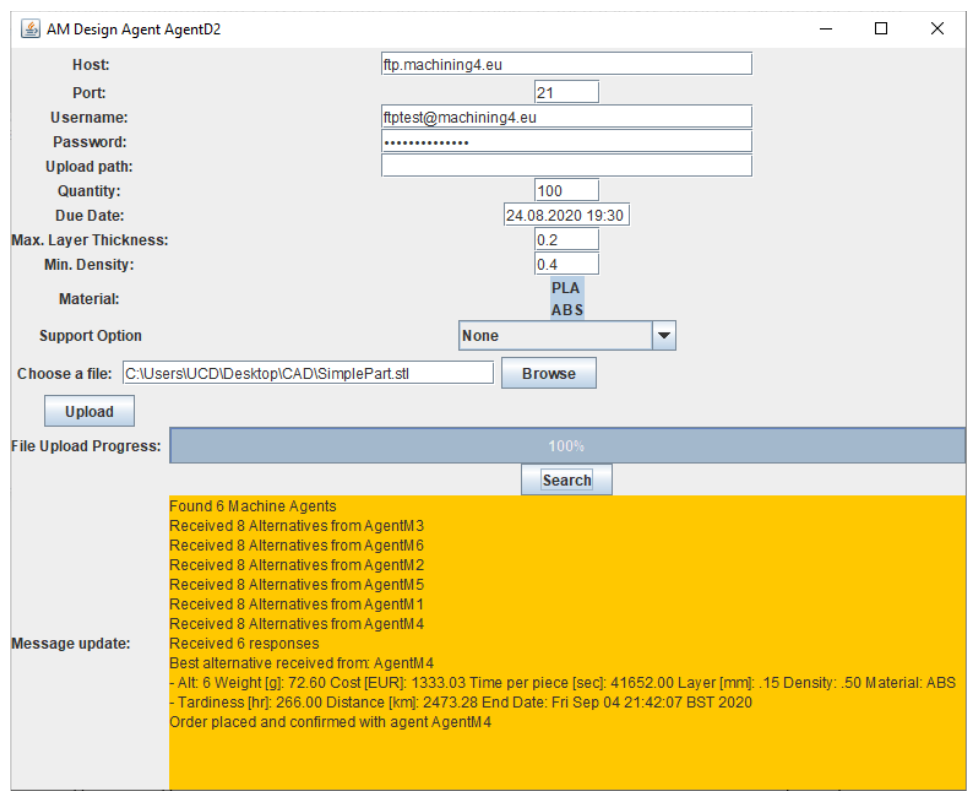
Figure 8. Test Case 1—Design Agent Graphical User Interface (GUI) with technical data and information from Machine Agents.